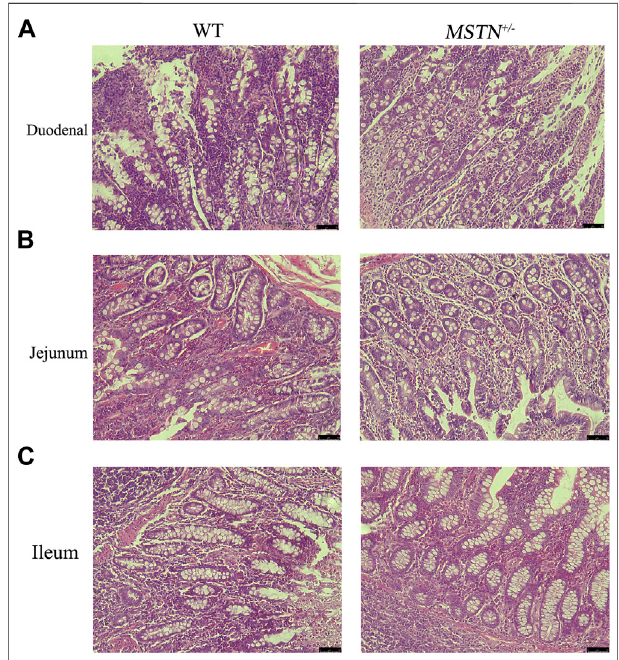
Frontiers in Genetics |